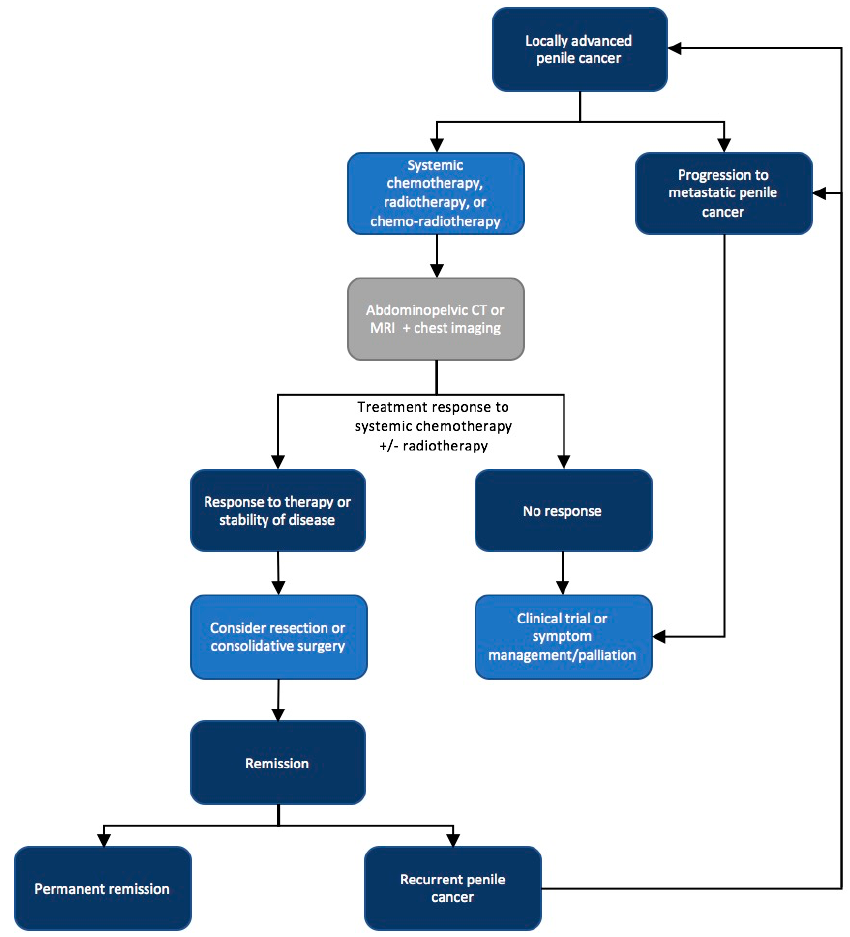
Figure 1. Current treatment paradigm in advanced loco-regional penile cancer. CT: Computed tomography; MRI: Magnetic resonance imaging.